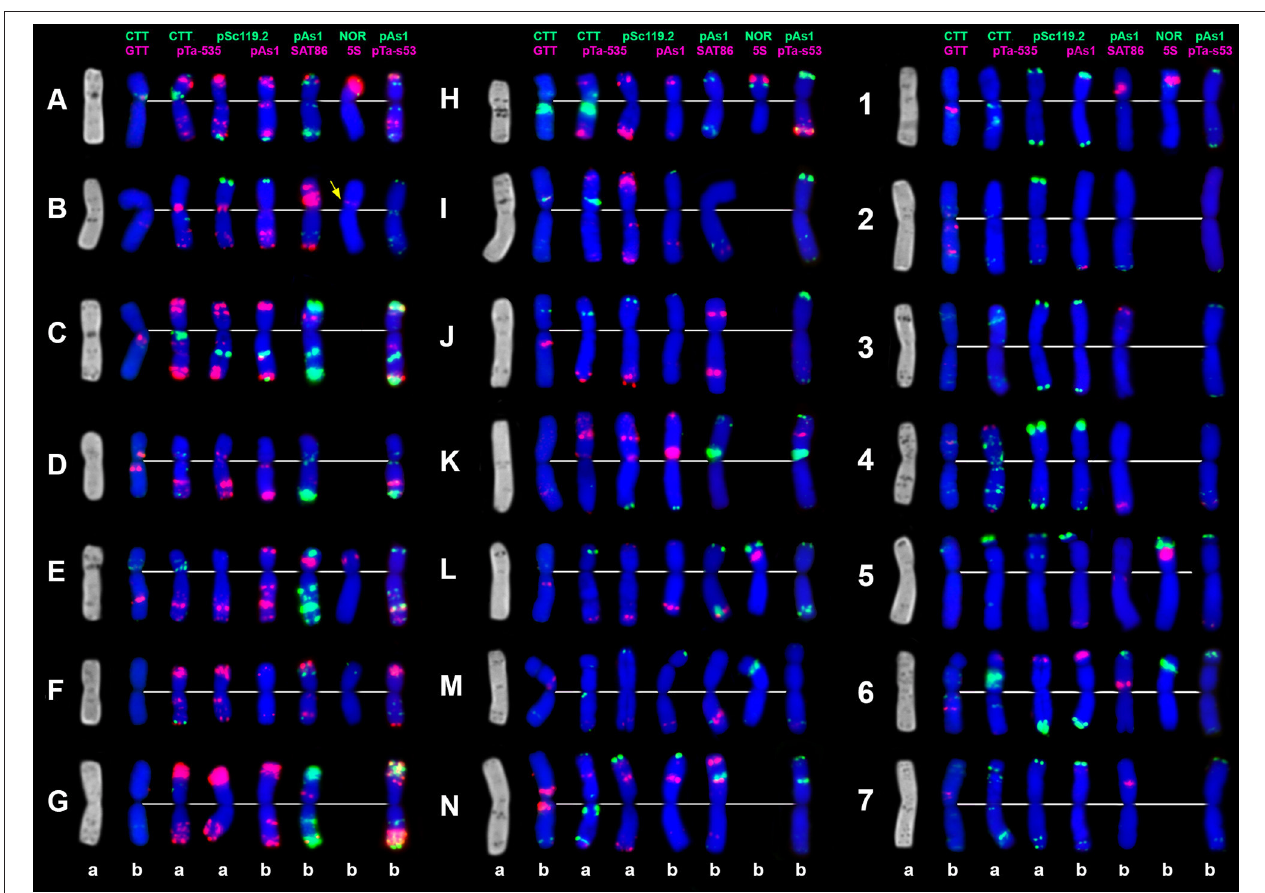
FIGURE 8 | C-banding (left) and FISH patterns of Ae. vavilovii chromosomes: a – K-3635; b – K-3637. Chromosomes are assigned to genome D 1 (left), X cr (middle), and to the S v genome (right) according to similarity with chromosomes of Ae. crassa ( Badaeva et al., 1998) and Ae. searsii (Friebe et al., 1995). Probe combinations are shown on the top, signal color corresponds to probe name. Chromosomes derived from Ae. crassa are designated with letters (A–N); the S v genome chromosomes are numbered 1–7 according to genetic nomenclature (Friebe et al.,